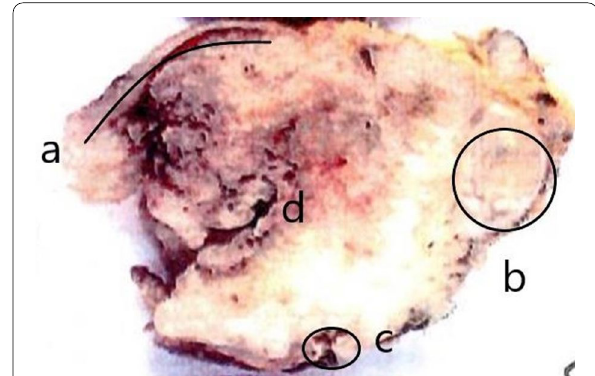
Fig. 7 Section of lesion. A tumor occupying the head of the pancreas and invading the duodenal lumen. a Mucosa of duodenum, b portal vein, c common bile duct, d tumor